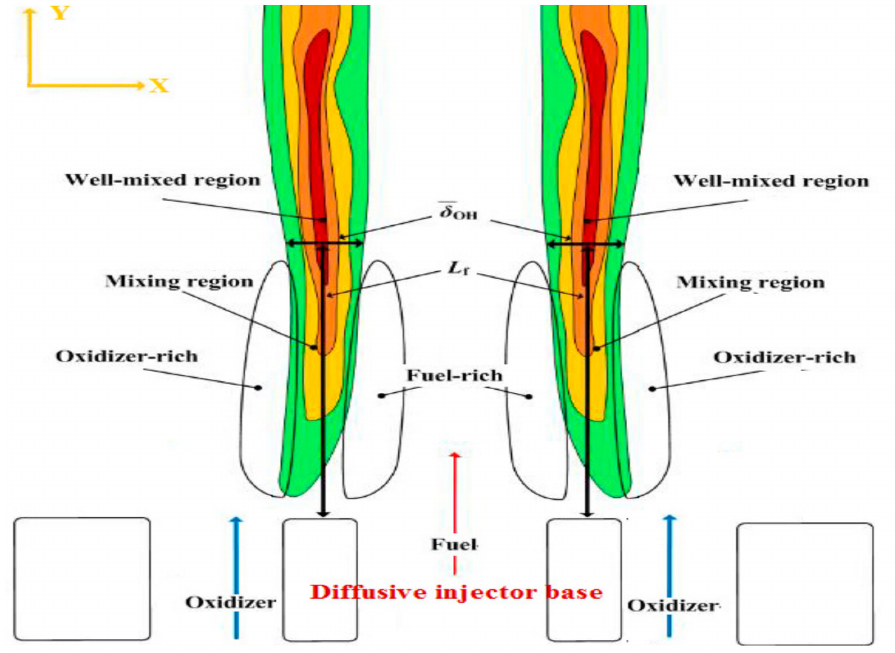
Figure 6. Schematic representation of the flame reproduced from